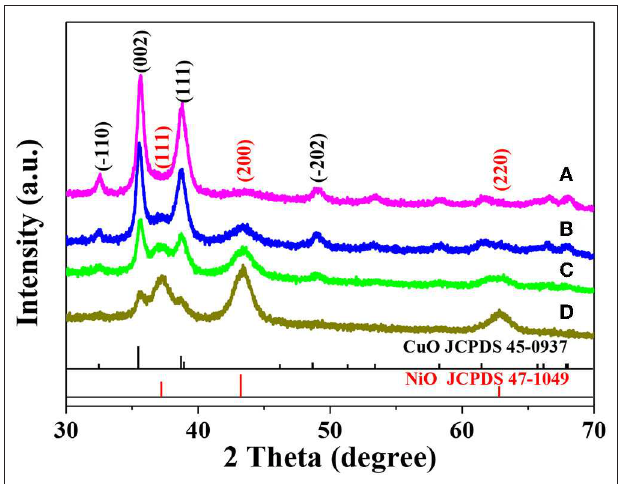
FIGURE 1 | XRD patterns of Ni 0.2 Cu 0.8 O (A) , Ni 0.4 Cu 0.6 O (B) , Ni 0.6 Cu 0.4 O (C) , and Ni 0.8 Cu 0.2 O (D)